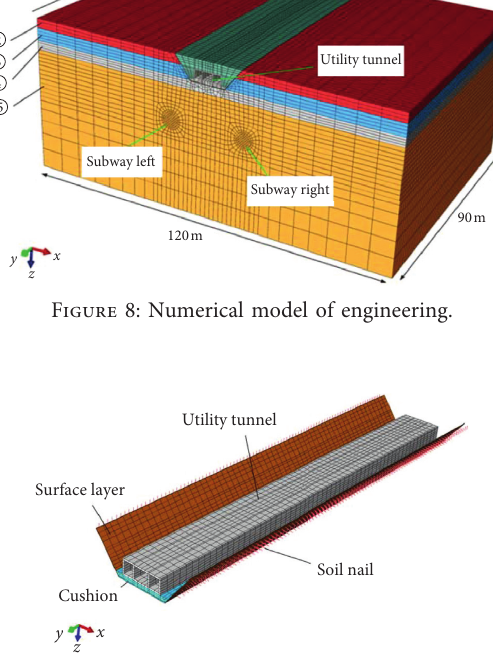
Figure 9: Structures of the foundation pit of the utility tunnel. Table 3: Soil basic physical property